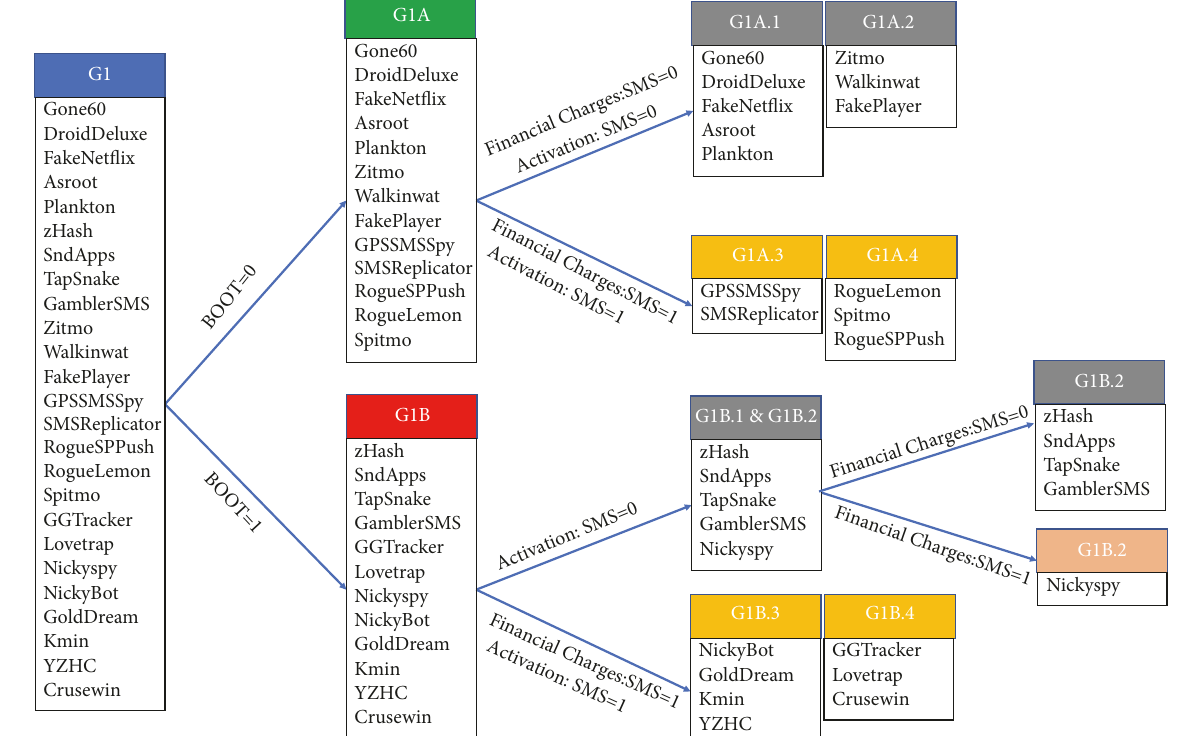
Figure 5: Families allocation in Group 1 and relevant features identified in BHL projection.